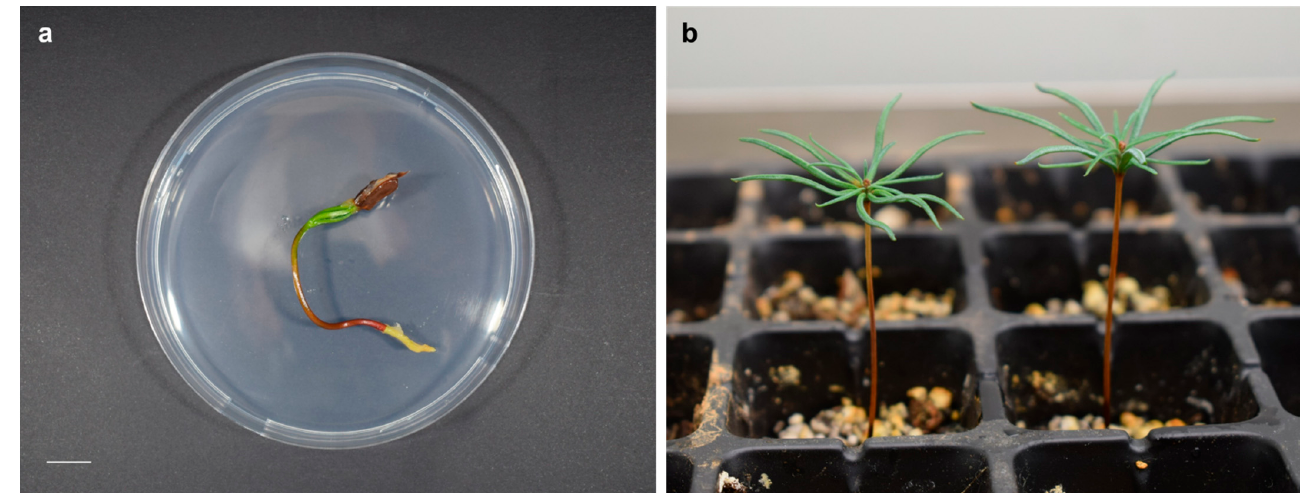
Figure 4. Seedlings obtained from A. pinsapo seeds germinated at 15 °C and under light conditions ( a ) at the end of the experiment and ( b ) four months after transference to ex vitro conditions. Bar = 1 cm.